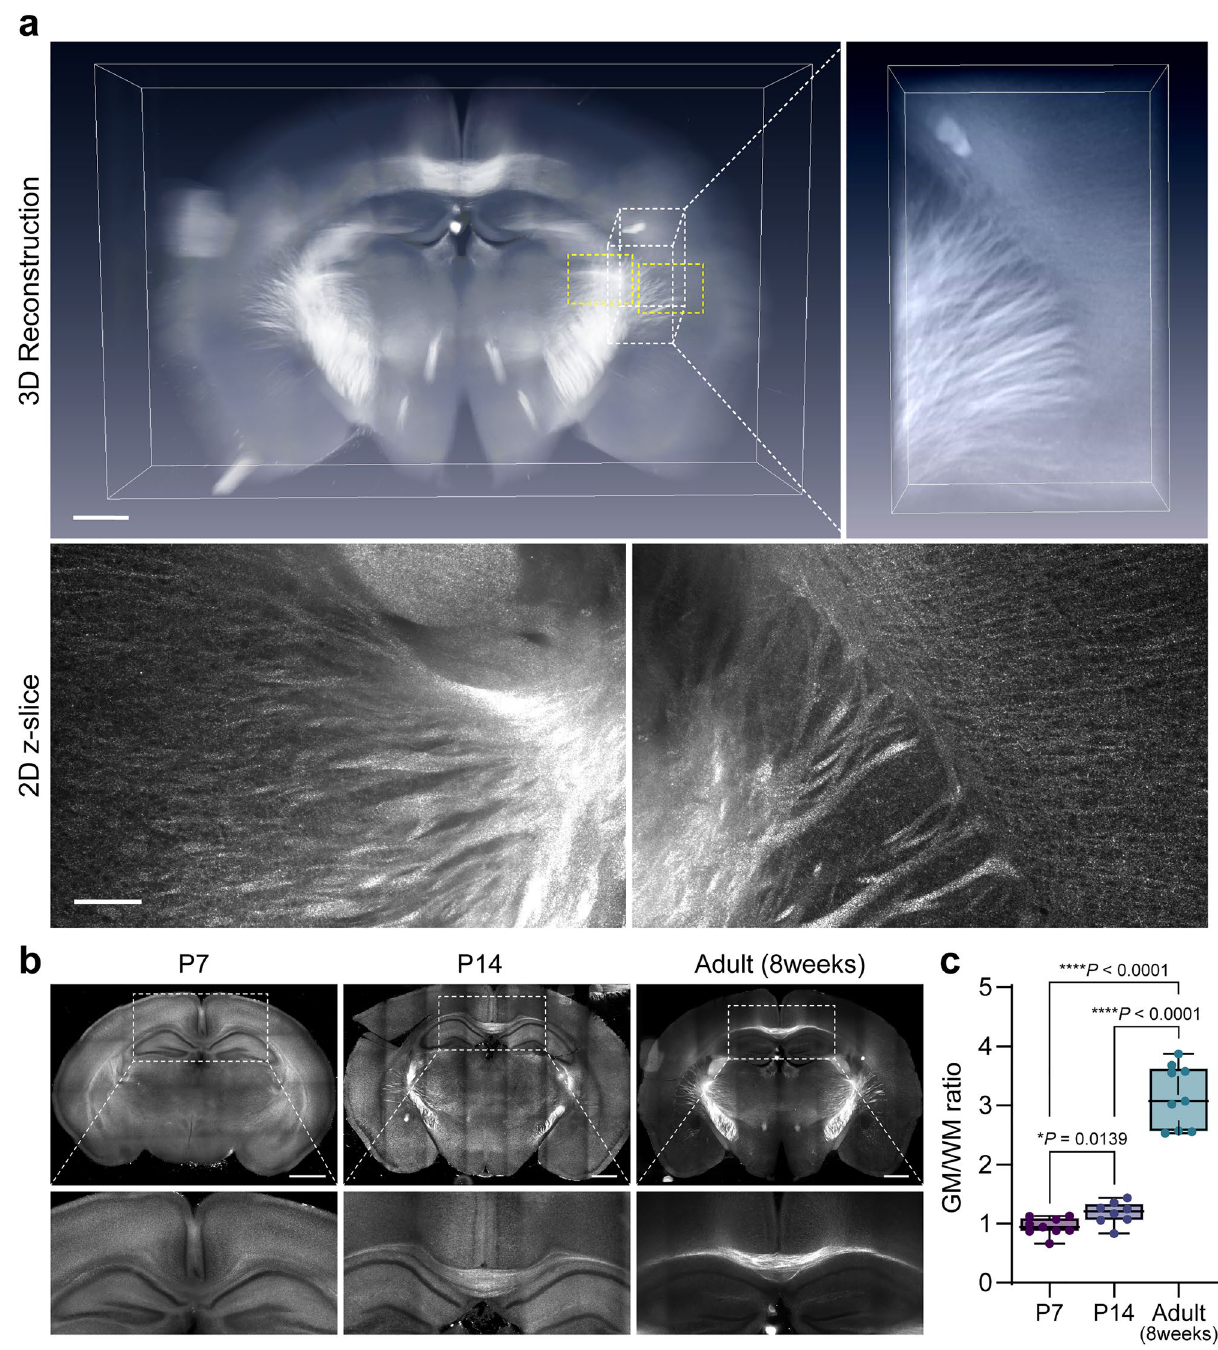
Figure 3. Label-free imaging of mouse brain in iMAX solution. ( a ) A 2-mm thick coronal slice of mouse brain is imaged with selective-plane illumination microscopy (SPIM) and processed with Amira software for 3D reconstruction. Boxed area with while dotted line is magnified and shown in the left panel. Single-plane images of the boxed areas with yellow dotted lines are shown at the bottom panels. Scale bar, 2 mm for upper panel and 200 μm for lower panel. ( b ) Development of mouse white matters during the 7 days, 14 days, and 8 weeks after birth as imaged by the label-free SPIM imaging. Lower panels are magnified images of corpus callosum region. Scale bars, 1 mm. ( c ) Quantification of grey matter/white matter (GM/WM) signal ratio. N = 8 each stage. T-test was used to analyze the difference between